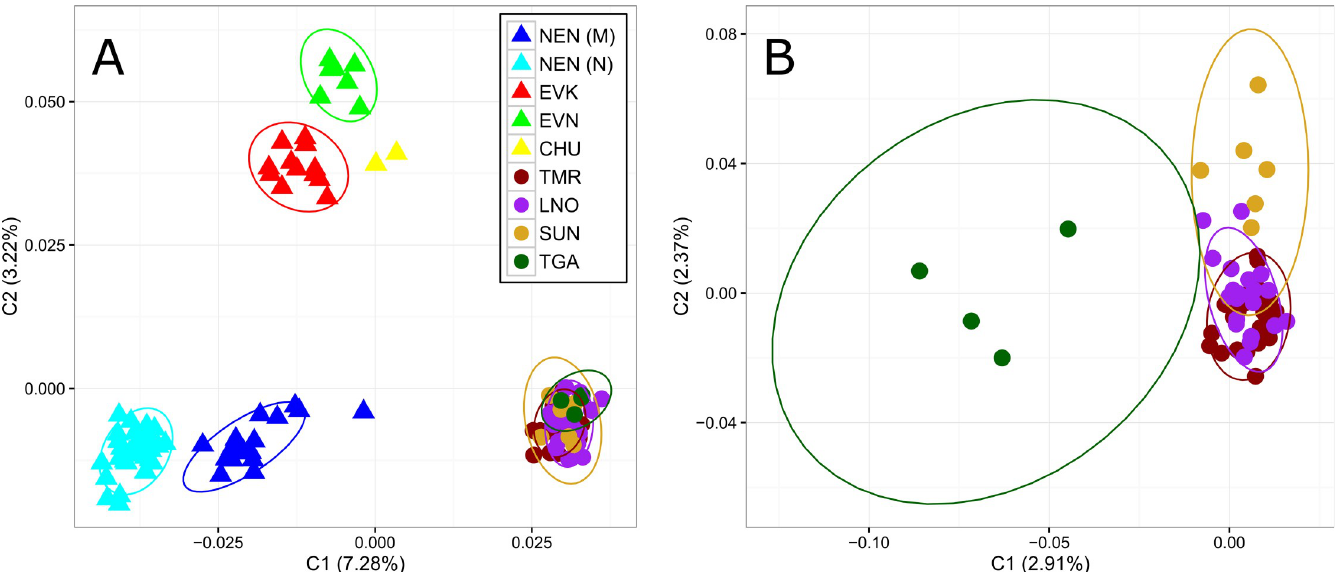
Fig 3. Multidimensional scaling analysis of reindeer populations: A–wild and domestic reindeer populations based on 8357 SNPs and B–wild population based on 8145 SNPs . Note: NEN_M–Nenets breed of the Murmansk region; NEN_N–Nenets breed of the Nenets Autonomous district; EVK–Evenk breed; EVN–Even breed; CHU–Chukotka-Khargin breed; and TMR–Taymyr Peninsula, LNO–Leno-Olenek, SUN–Sundrun, and TGA–taiga (boreal forest) wild populations.